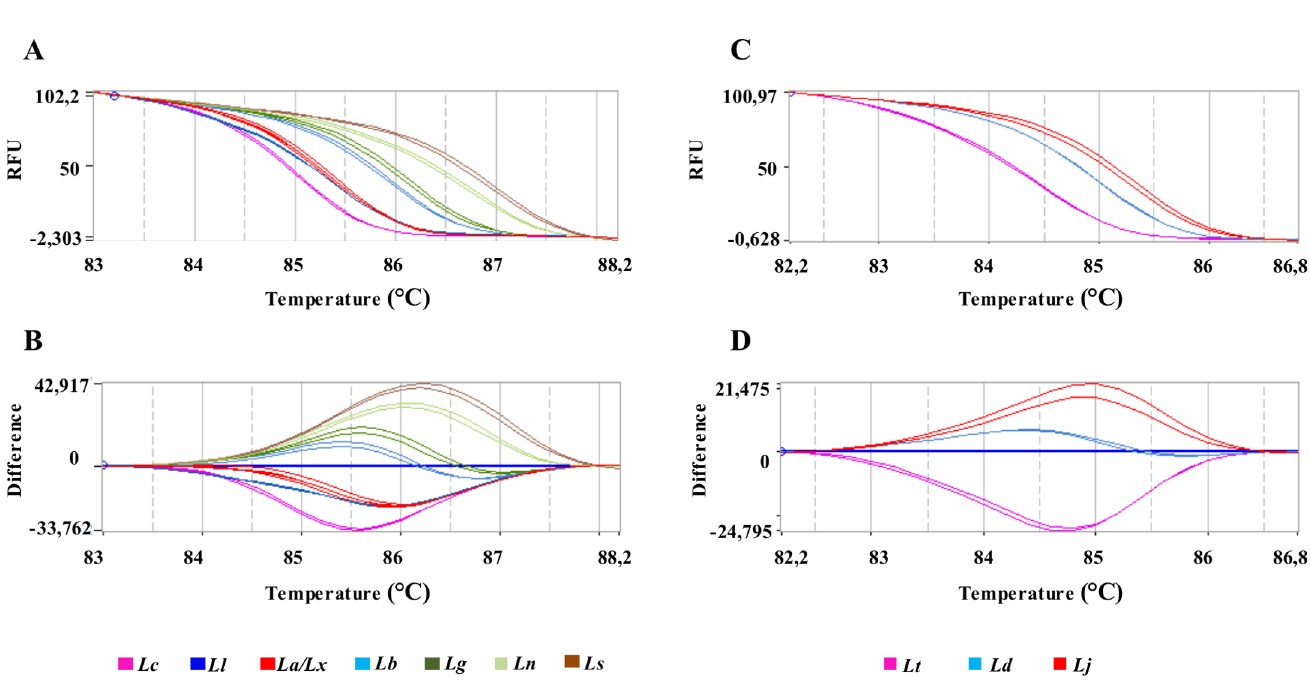
Fig 3. HRM plots of hsp70 amplicon 1. Representative melting profiles of hsp70 amplicon 1 obtained with DNA from Leishmania species present in Brazil (A, B) or DNA from Leishmania species of Eurasia and Africa (C, D). (A, C): Normalized melting curves; (C, D): normalized difference curves. ( Lt ): L . (L . ) tropica ; (Ld ): L . (L . ) donovani ; ( Lc ): L . (L . ) infantum chagasi ; ( Lj ): L . (L . ) major ; ( La ): L . (L . ) amazonensis ; (Lx ): L . (L . ) mexicana ; ( Ll ): L . (V . ) lainsoni ; ( Lb ): L . (V . ) braziliensis ; ( Lg ): L . (V . ) guyanensis ; ( Ln ): L . (V . ) naiffi and ( Ls ): L . (V . ) shawi . Each sample was tested in